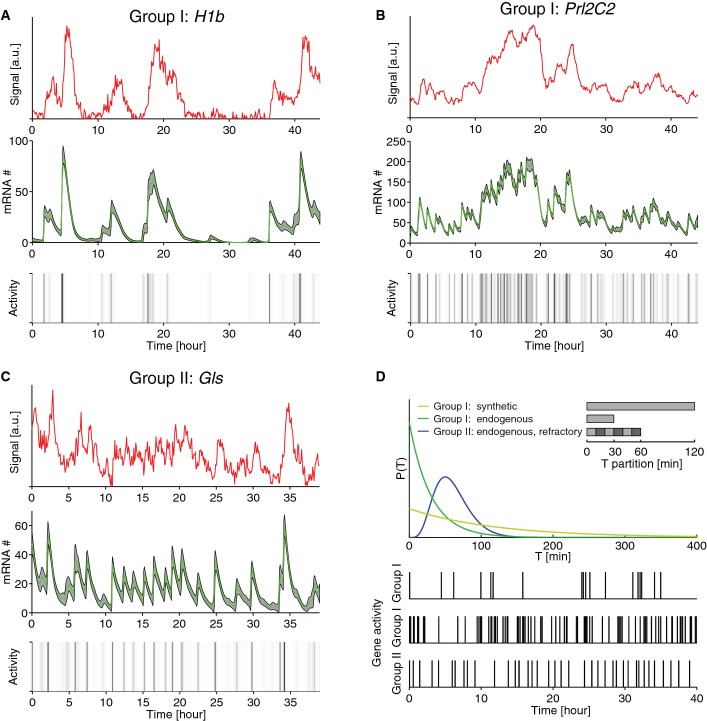
The kinetic structure of the silent intervals reveals different classes of promotersThree classes emerge from the characterization of the promoter cycle: synthetic promoters with a single long silent interval (Group I, synthetic), endogenous promoters with a shorter single interval (Group I, endogenous), and endogenous promoters displaying a refractory period (Group II).
A–C Deconvolution of individual cell traces illustrating the three groups of promoter cycles for three promoters (H1b, Prl2C2, Gls). Measured single-cell bioluminescent time traces (red), deconvolved mRNA (green), and gene activity (gray shading indicates probability of the ‘on’ state, black is highest).

D Scheme showing the three groups: Top, distributions of silent intervals. Bottom, Simulations of gene activity patterns for the three groups show qualitative differences.